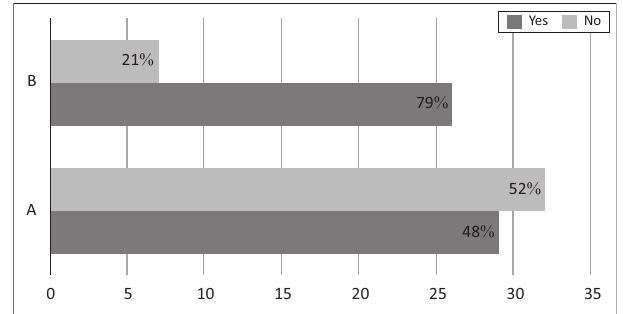
FIGURE 3: Coping with children with